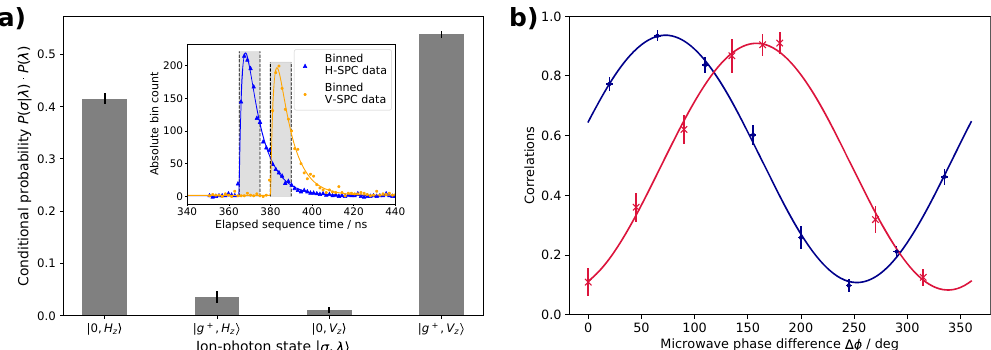
Fig. 2 Veri fi cation of entanglement. a Correlations for the σ z ⊗ σ z basis are shown with time-binned arrival times of the photons for this measurement as inset. We measure a FWHM of 9.9(7) ns for the photon duration. From the atomic decay constant the light – matter coupling rate can be estimated (see Methods for details). The gray shaded areas represent the post-selection boundaries (10ns width) for photons accepted for analysis (see main text for details). b) The parity oscillations for a photon readout in σ x and σ y bases are shown. The relative phase difference Δ ϕ = ϕ 1 − ϕ 2 of the microwave pulses sets the readout basis of the atomic qubit in the equatorial plane of the Bloch sphere. Red crosses: P (0 ∣ H x ) ⋅ P ( H x ) + P ( g + ∣ V x ) ⋅ P ( V x ) correlations. Blue dots: P (0 ∣ H y ) ⋅ P ( H y ) + P ( g + ∣ V y ) ⋅ P ( V y ) correlations. Error bars show the standard